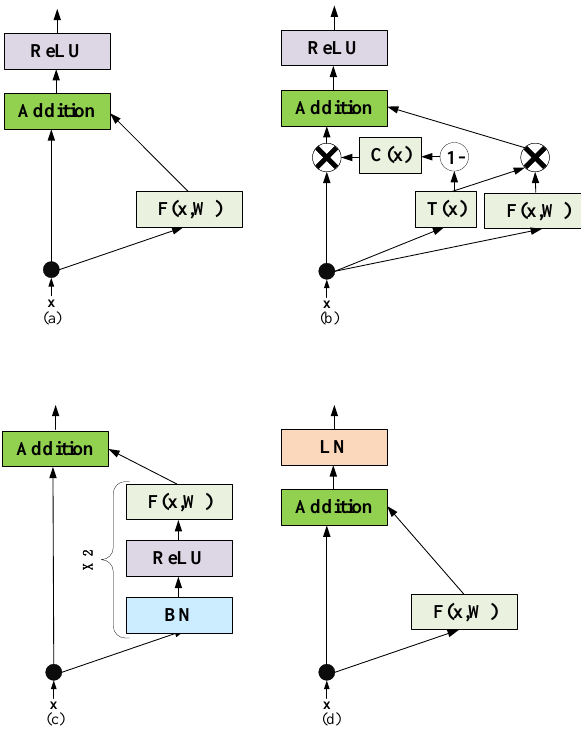
Figure 4. Common skip connection